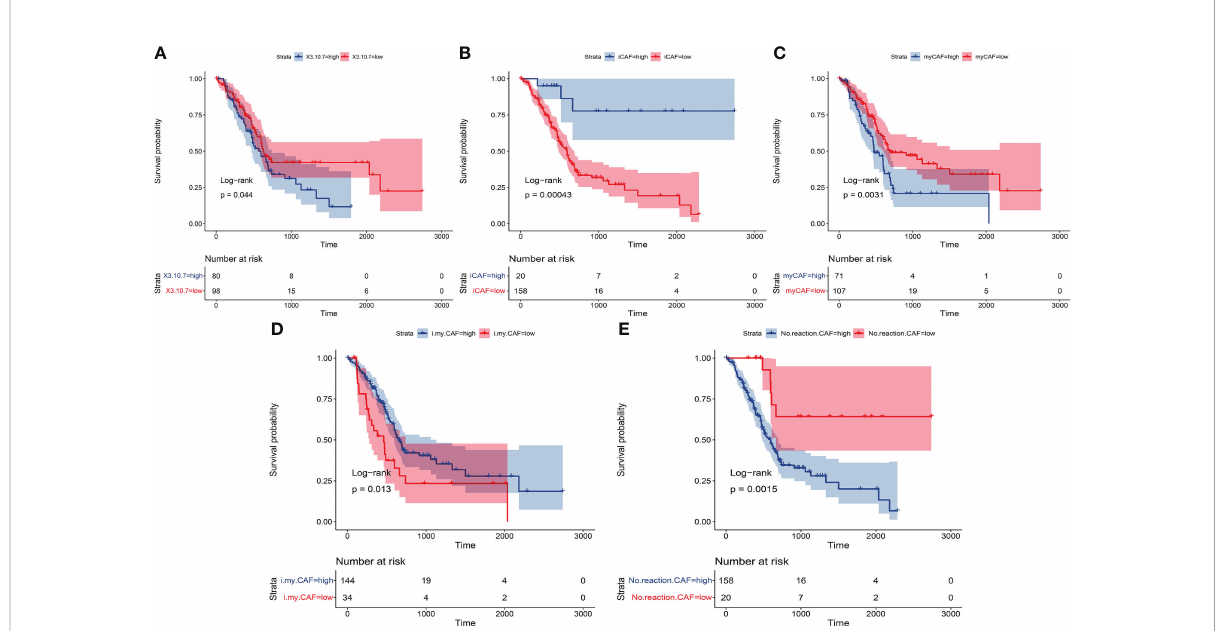
FIGURE 6 The Kaplan – Meier plot shows that the previously identi fi ed subgroups had signi fi cant prognostic value in patients. (A) ASPC-speci fi c cancer cell subtypes (combined expression of groups 3, 7, and 10). (B) Identi fi ed iCAF subgroup. (C) Identi fi ed myCAF subgroup. (D) Identi fi ed imCAF subgroup. (E) Identi fi ed nCAF subgroup. ASPC, pancreatic adenosquamous carcinoma; iCAF, in fl ammatory cancer-associated fi broblast; myCAF, myo fi broblastic cancer-associated fi